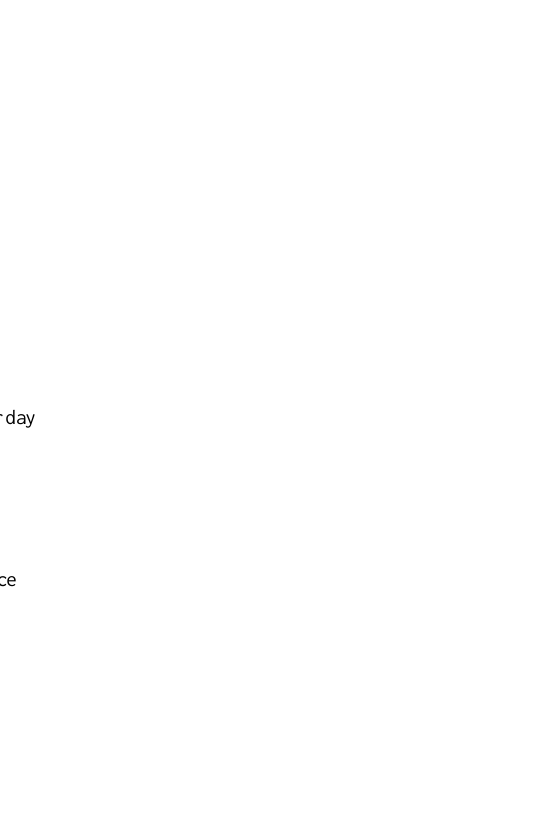
Figure 1. Min-max scaler for normalizing each feature, where all values for each feature are normalized between 0 and 1.